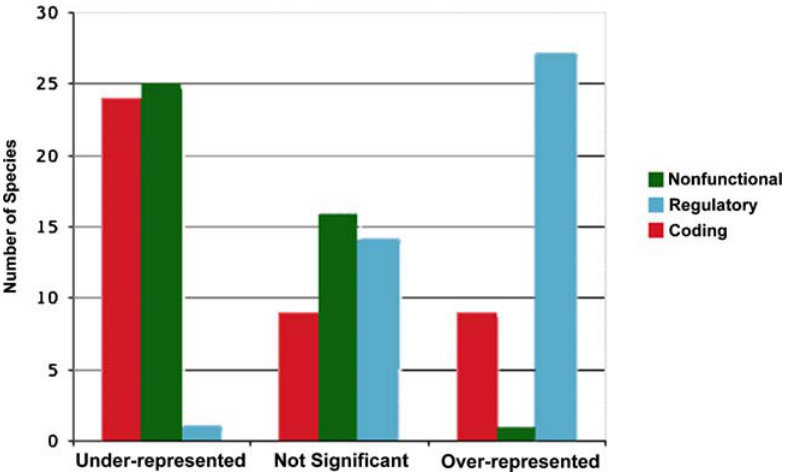
Figure 3. Patterns of over- and under-representation of 2 10 motifs across species. For every species, observed and expected 2 10 motif frequencies in the three different genomic regions were compared as in Figure 1. Over- and under-representation were considered significant when the observed frequency was beyond 6 2 SD from the mean value for shuffled sequences.